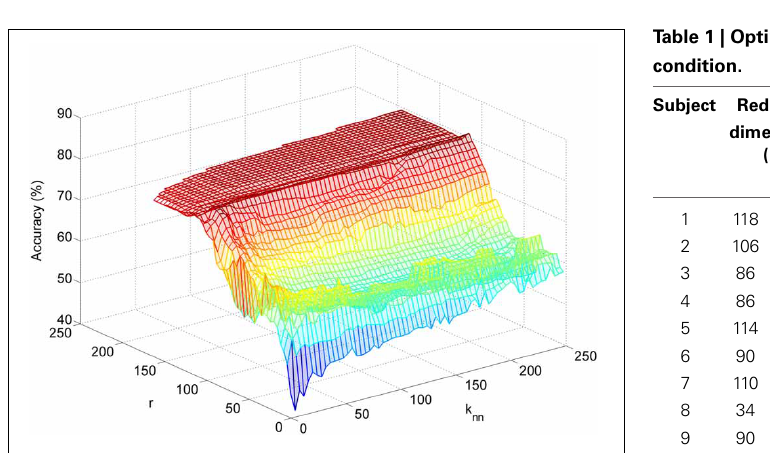
FIGURE 6 | Example of a subject-specific accuracy surface created during LFDA-GMM classifier optimization. The accuracy plotted at each point { r, k nn } on the surface is the average accuracy with the optimal number of mixture components ( K ) for each class at that point.